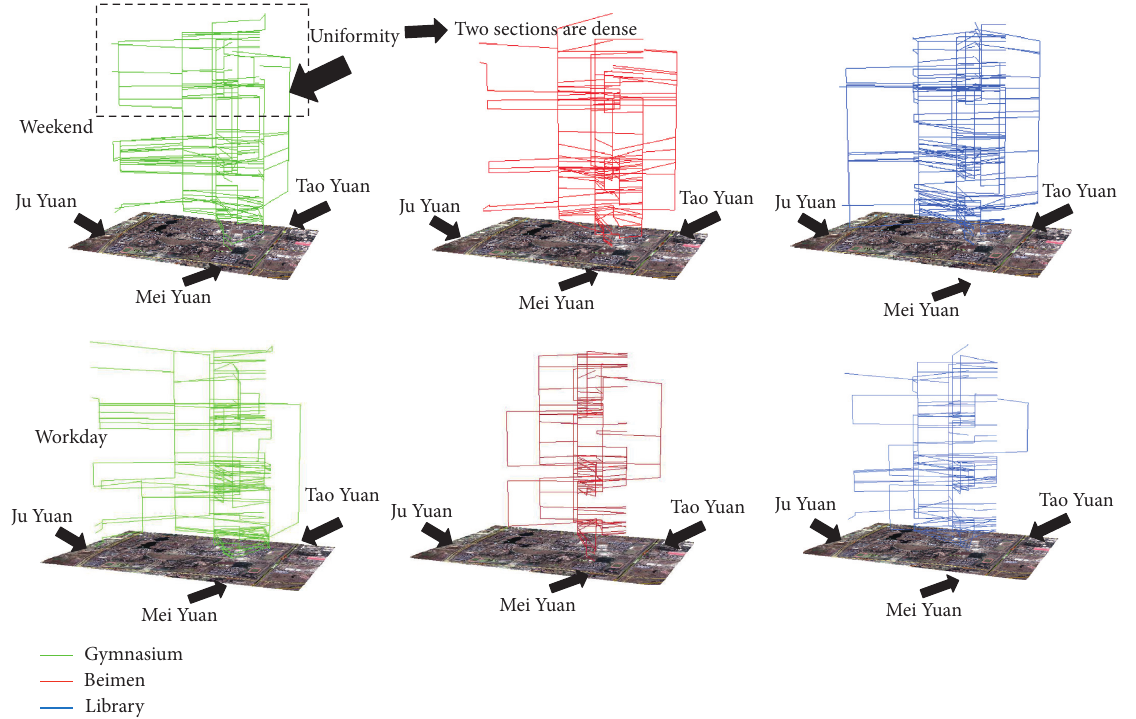
Figure 7: Activity travel path map of bus customization platform in different